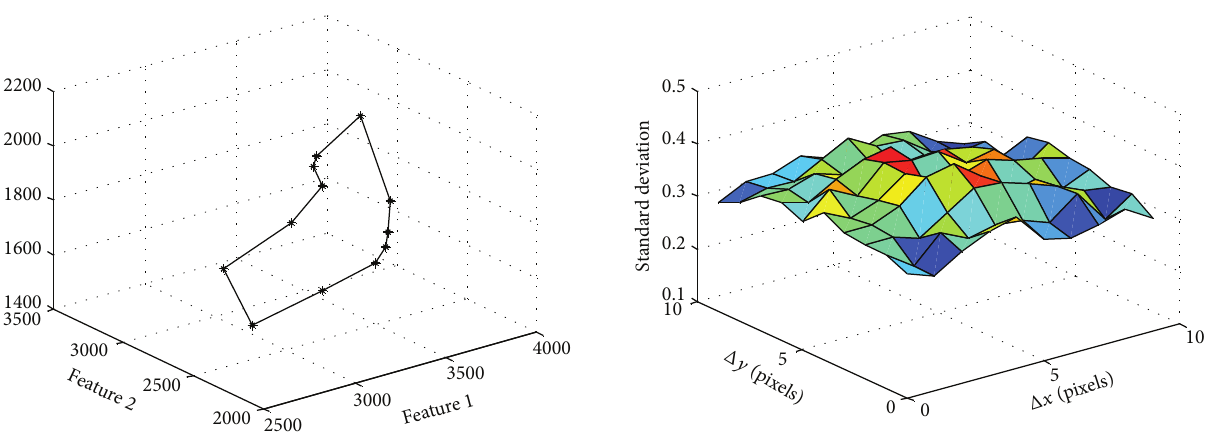
Figure 10: The relationship between accuracy and shift length along 𝑥 - and 𝑦 -axis.